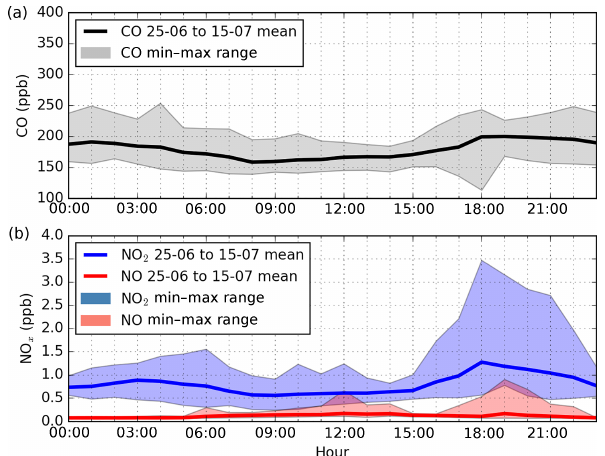
Figure A5. Hourly diurnal cycles of (a) carbon monoxide (CO in black), (b) nitrogen dioxide (NO 2 in blue), and nitrogen monoxide (NO in red) concentrations (ppb) observed at Savè (Benin). Means of each hour are presented by the lines over the entire campaign period (25 June to 15 July 2016). The upper and lower shading limits correspond to the hourly ranges (maximum and minimum of each hour over the